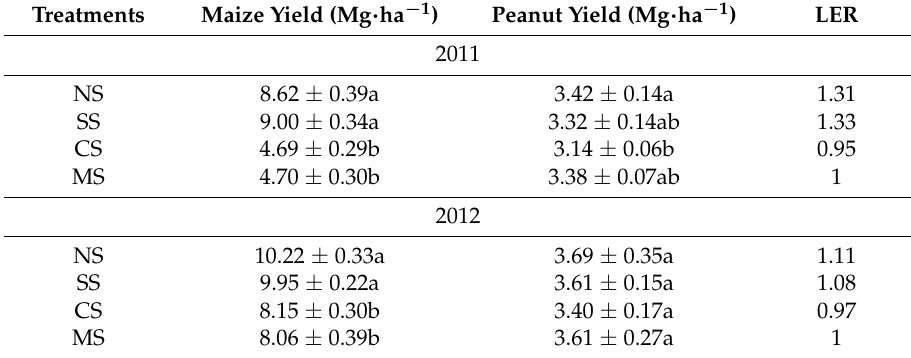
Table 1. Maize and peanut yields under different intercropping treatments.